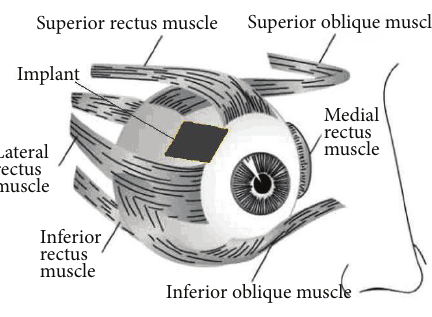
Figure 6: Proposed location for the implant (taken from [24]).